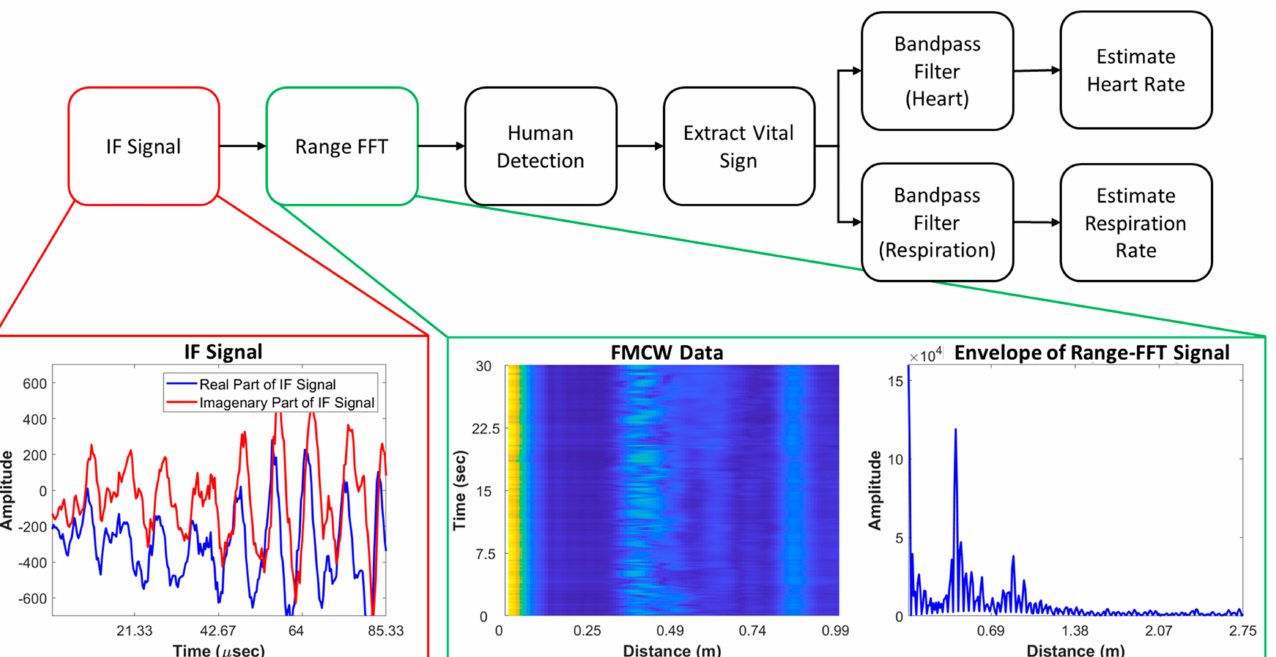
Figure 4. Process of heart rate (HR) and breathing rate (BR) extraction using the IF signals of radar and intermediate outputs.